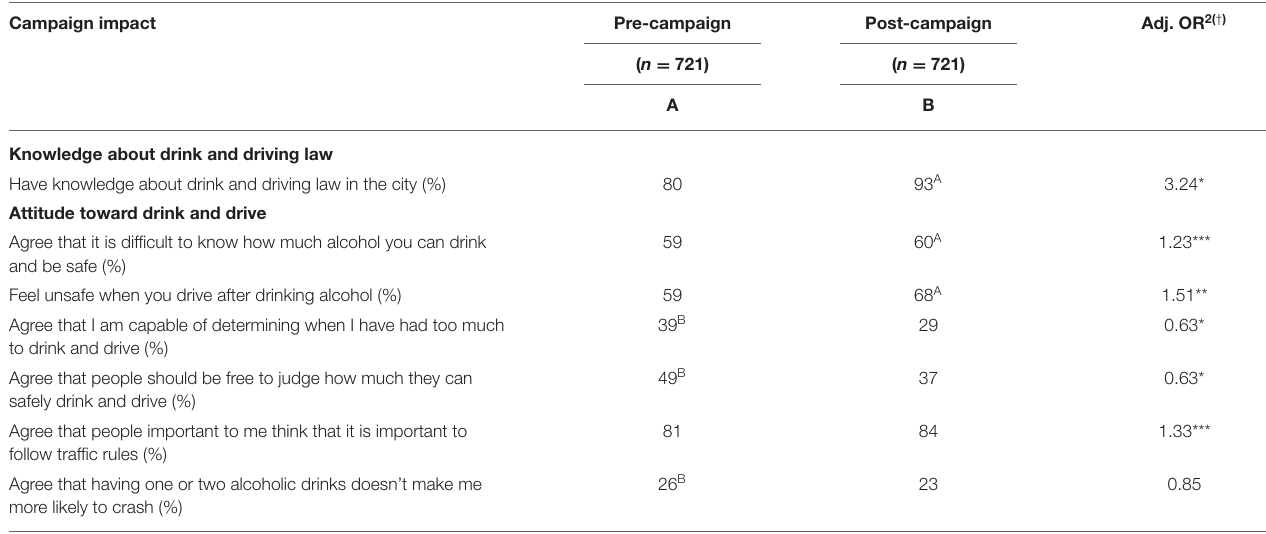
TABLE 4A | Campaign impact on knowledge and attitudes and support for government action, by pre-campaign and post-campaign period. Campaign